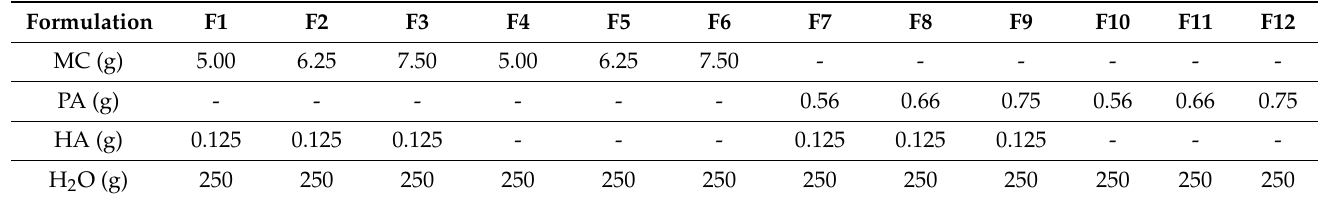
Table 1. The composition of formulations